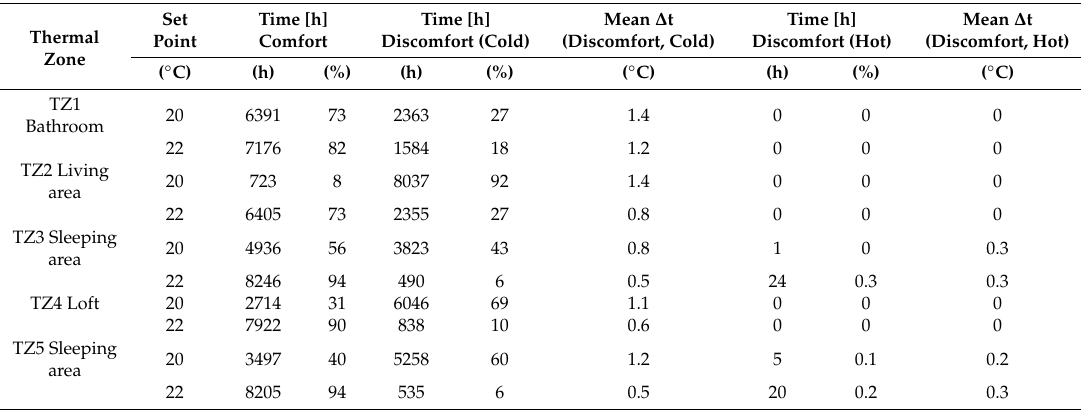
Table 9. Comfort hours for 20 °C and 22 °C temperature set point, in each thermal zone (TZ) referred to in Figure 3 ( Δ t = temperature difference).